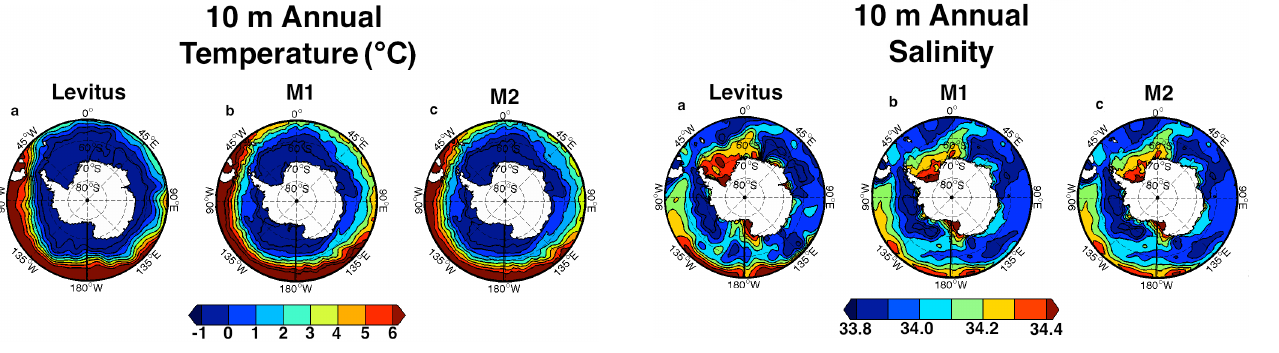
Fig. 3. Near surface (10m) annual mean temperature fields in centigrade for (a) Levitus climatology, (b) M1, and (c) M2 simulations. Fig. 4. Near surface (10m) annual mean salinity for (a) Levitus climatology and (b) M1, (c) M2 simulations.